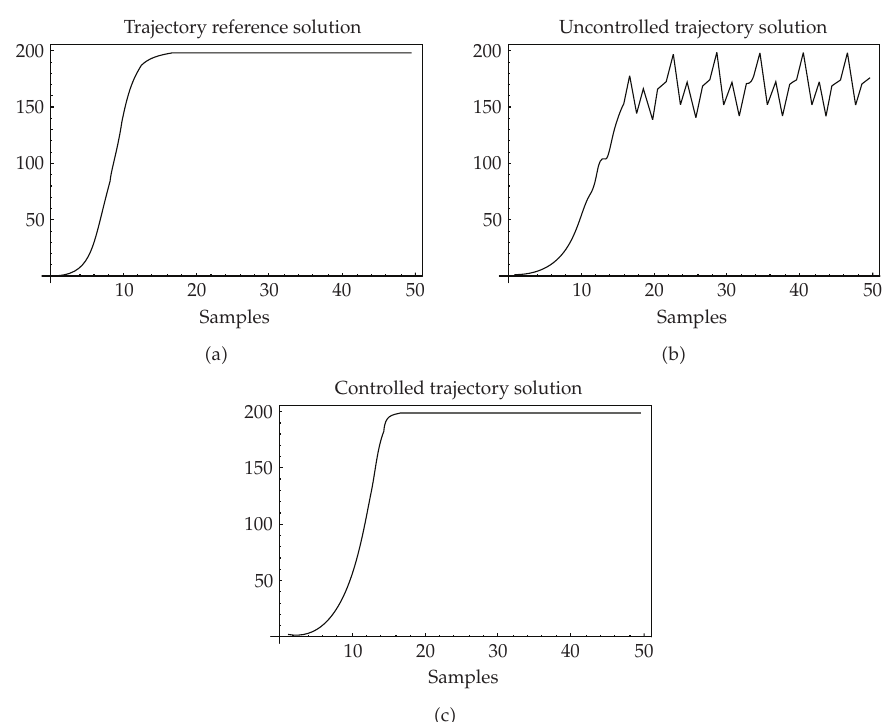
Figure 3: BHE Solutions: (cid:2) a (cid:3) reference, (cid:2) b (cid:3) uncontrolled, and (cid:2) c (cid:3) controlled for initial covariance gain 1000.